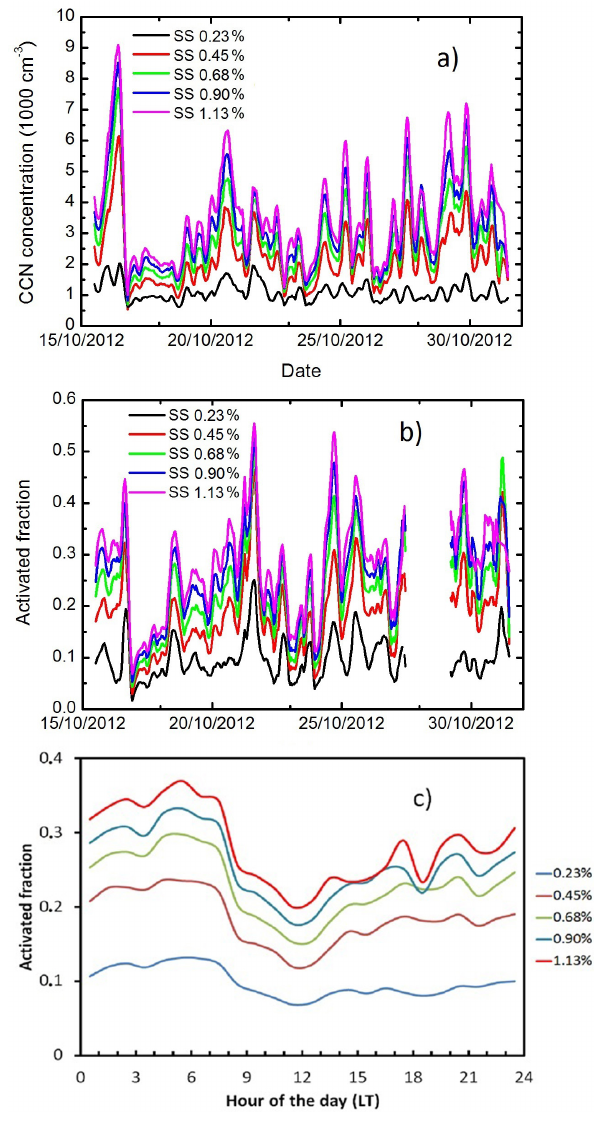
Figure 2. Time series of (a) CCN number concentration, (b) the ac- tivated fraction (#CCN/N10 − 500) and (c) the mean hourly average over the whole period. The different colours represent the different